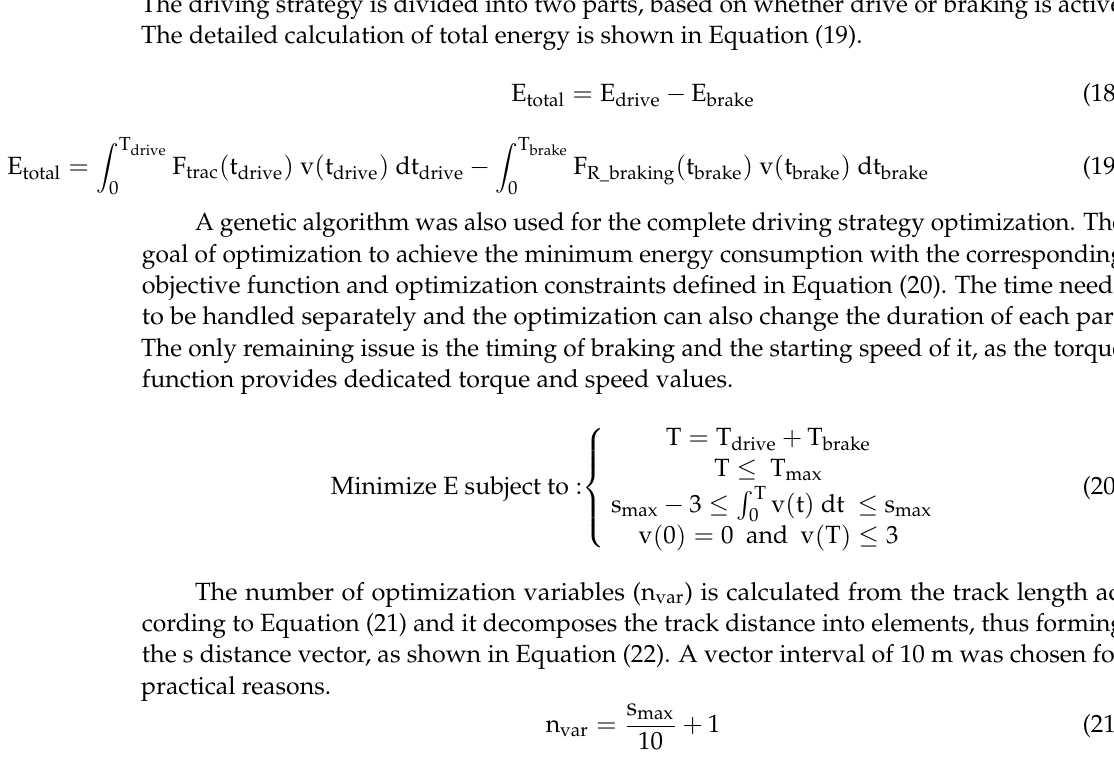
Figure 11. Summarized recovered energy from the sensitivity analysis: ( a ) mass variation; ( b ) resistance force variation.